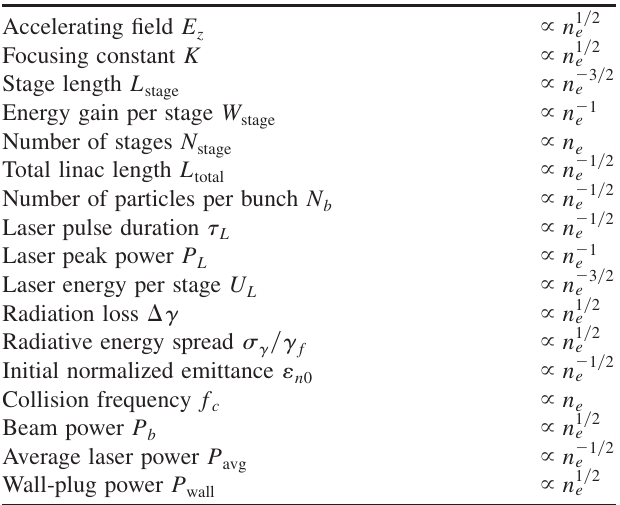
TABLE II. Scaling dependence of LPA parameters on the operating plasma